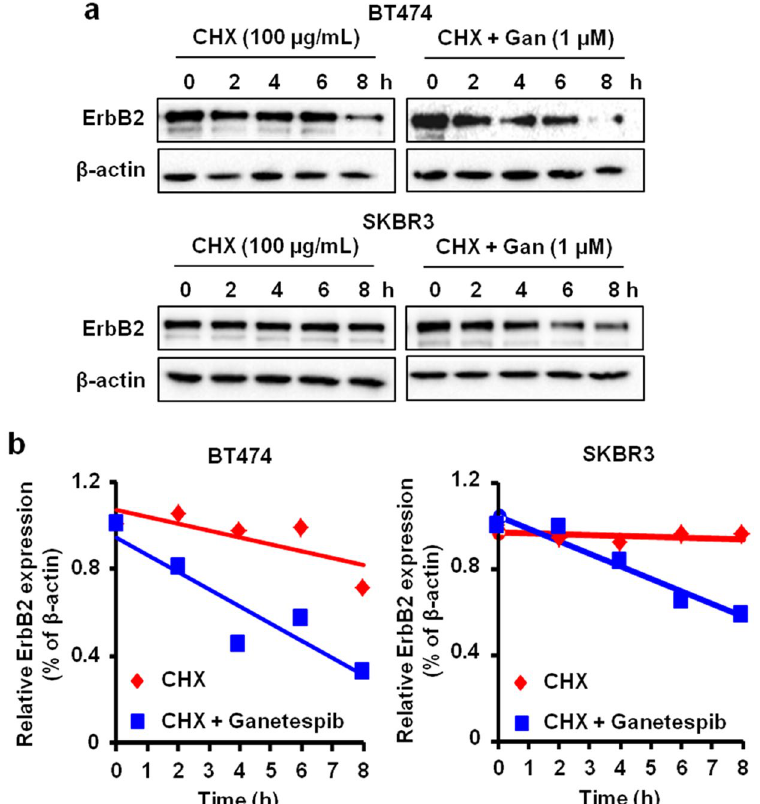
Figure 5. Ganetespib decreases the protein stability and half-life of ErbB2 in ErbB2 + breast cancer cells. ( a ) BT474 and SKBR3 cells were treated with CHX (100 μ g/mL) + / − ganetespib (1 μ M) for the indicated treatment durations. Then, ErbB2 protein expression was analyzed using Western blotting. Cropped images of ErbB2 and β -actin protein expression are shown. ( b ) ErbB2 protein band intensities were quantified using ImageJ software and normalized to corresponding β -actin protein band intensities. Relative ErbB2 protein expression after CHX + / − ganetespib treatments for each cell line is